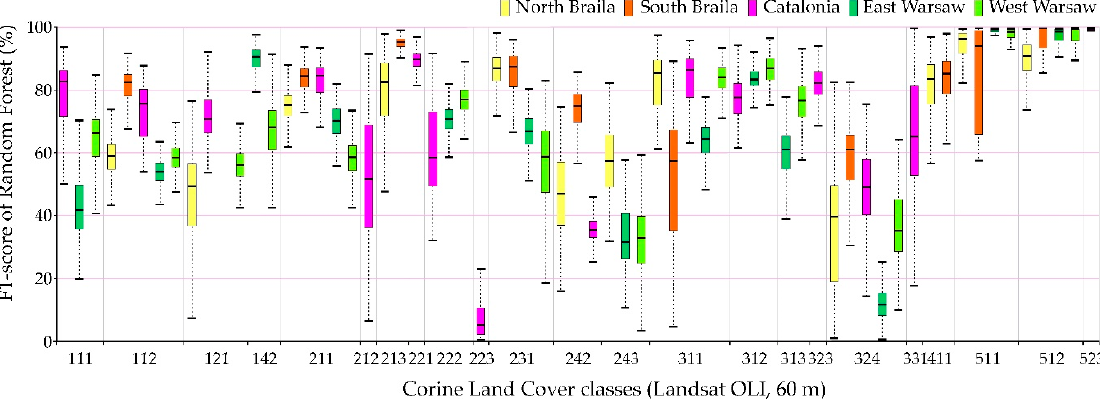
Figure 12. The best classification results (F1-score) achieved from the Random Forest classifier and multitemporal Landsat OLI images.